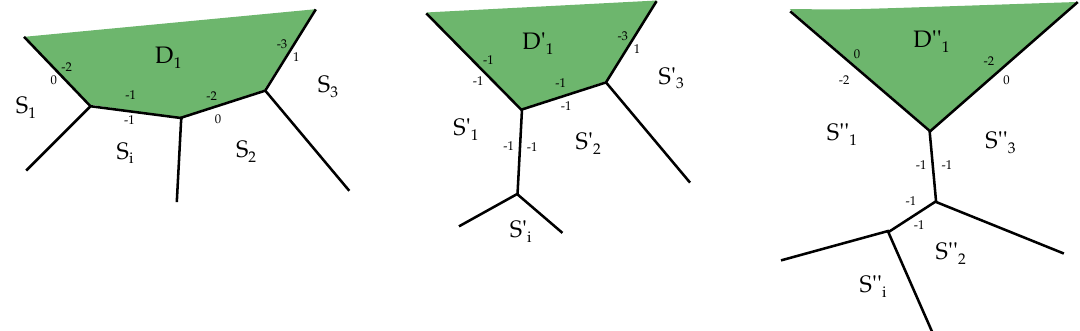
Figure 2. The necessary (cid:13)op operations to determine the multiplicity factor (cid:24) i; 1 of the non- compact surface D 1 on S i . The procedure includes two conifold transitions, where we do not draw the singular geometry